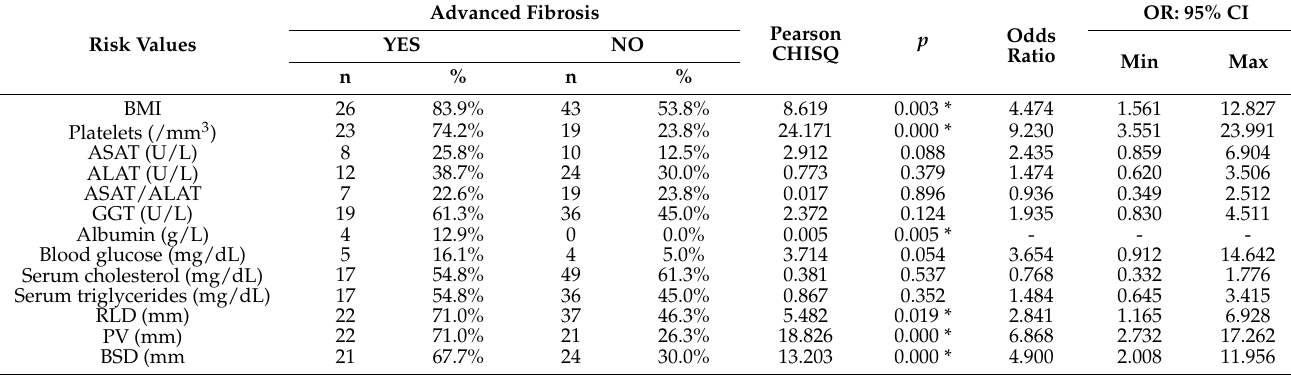
Table 4. Risk values for advanced fibrosis